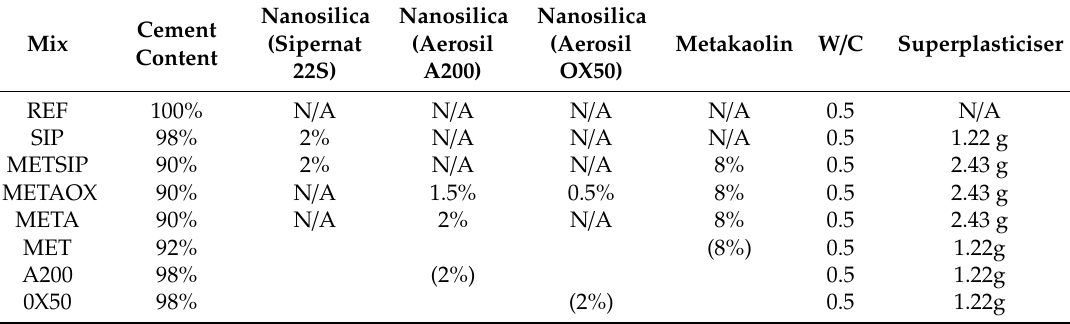
Table 1. Mix design